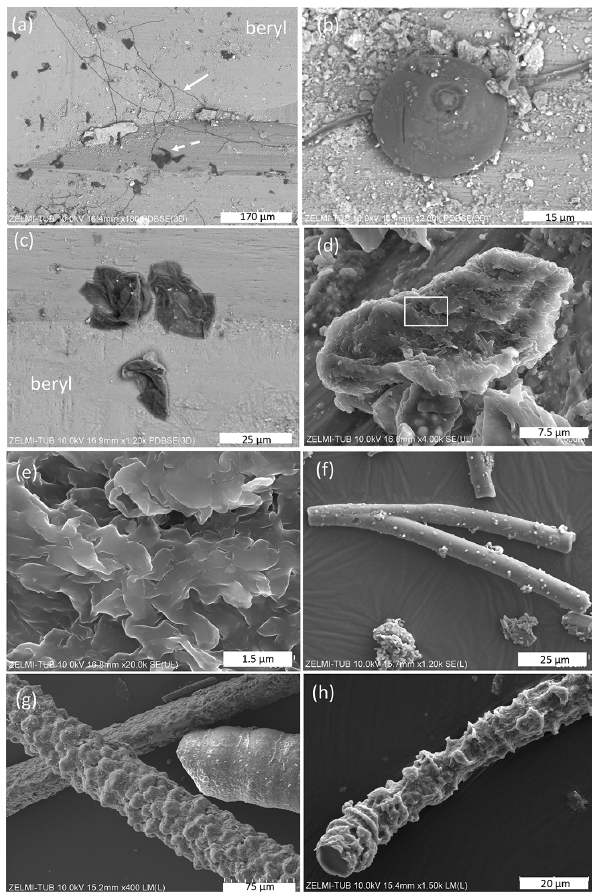
Figure 4. SEM images of minerals associated with kerite. (a) Chlorite and kaolinite and (b) unidentified Na–Fe–Al silicate grain grown onto a filament (sample #0). (c) High magnification of fil- ament surface with Fe sulfide (pyrite/marcasite?) and incrustations of Si–Al (sample #0). (d) Incrustation on segmented filament, with dominantly Si–Al, minor peaks of Fe–P–S–K (sample #4). (e) Ag- gregate of filaments, cemented by minerals; lower right is an albite crystal; rectangle shows position of (f) , enlarged part with broken filaments and small opal grains (identified by a Si peak and globular shape) attached to the surface (sample #4). (g) Aggregates forming a botryoidal surface of a filament, intergrown with a fluorite crys- tal. (h) Alkali feldspar, grown onto a broken filament with central